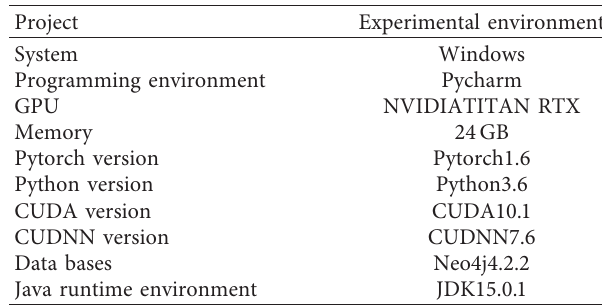
Figure 7: Data set visualization. Table 2: Experiment environment